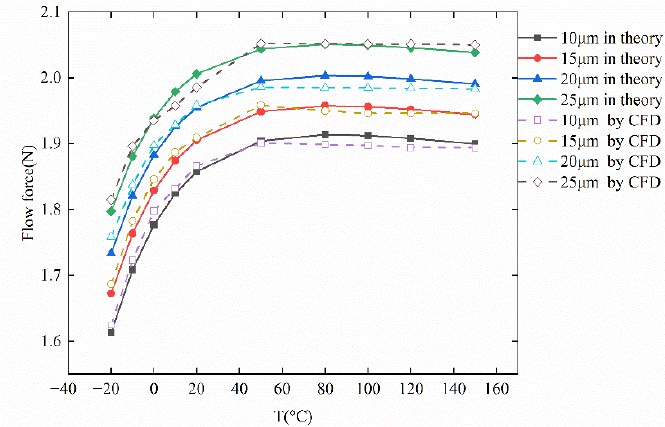
Figure 15. The effect of temperature and deflection on flow force.